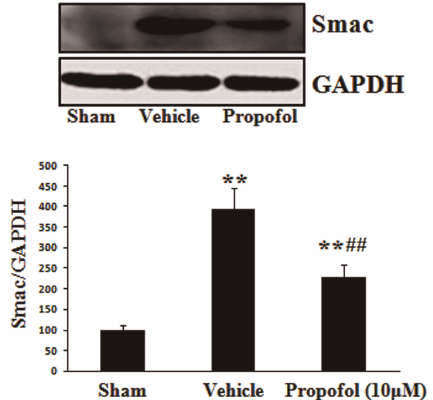
Figure 4. Effect of propofol on burn serum-induced second mitochondrial-derived activator of caspases (smac) release. Compared with the sham group, smac cytosolic content increased after burn serum exposure. Propofol pretreatment led to decreased smac content compared with burn serum-exposed cells. Data are reported as means±SD (n=5 in each group). **P , 0.01, compared to the sham group; ## P , 0.01 compared to the vehicle group (one-way ANOVA).